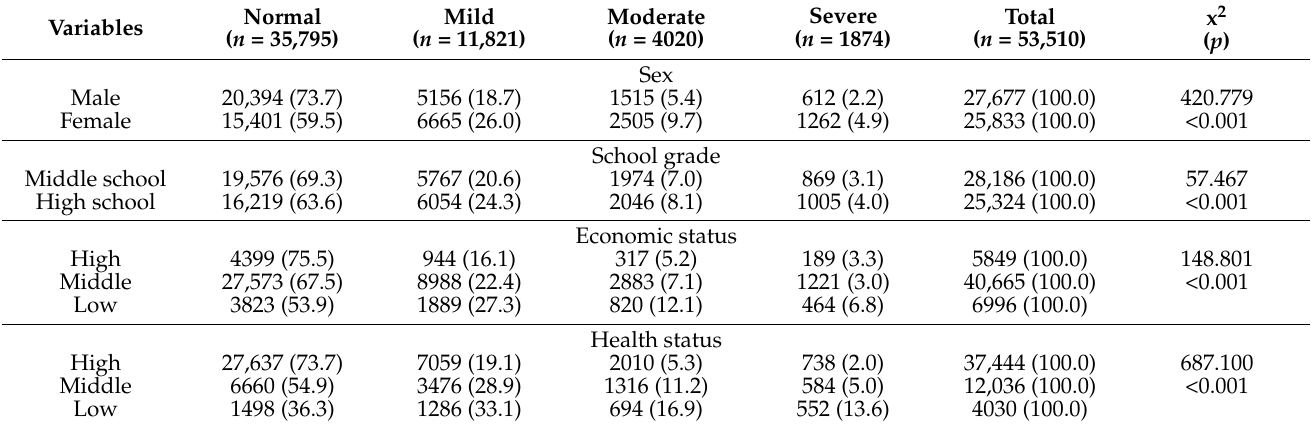
Table 1. General characteristics of the Korean adolescents according to level of GAD-7.